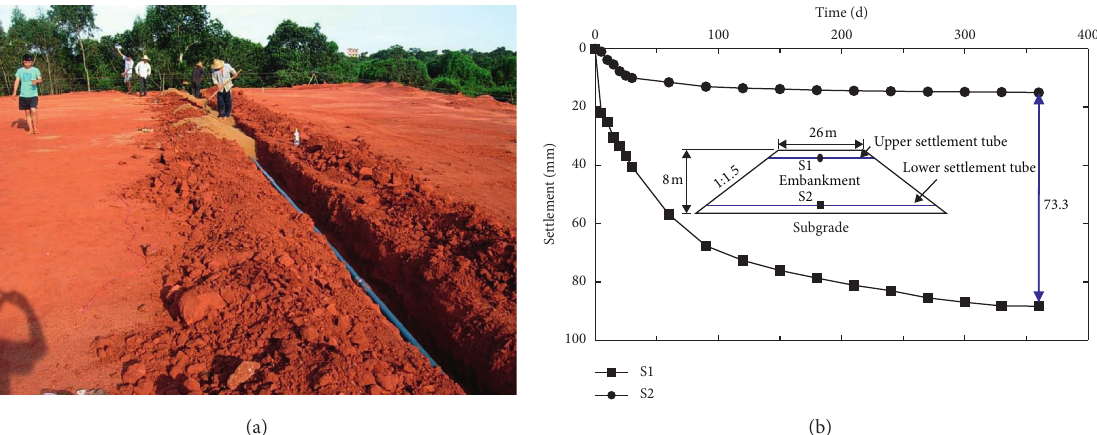
Figure 12: Field monitoring on the settlement of the Wanning–Yangpu highway embankment. (a) Installation of the upper settlement tube. (b) Monitored